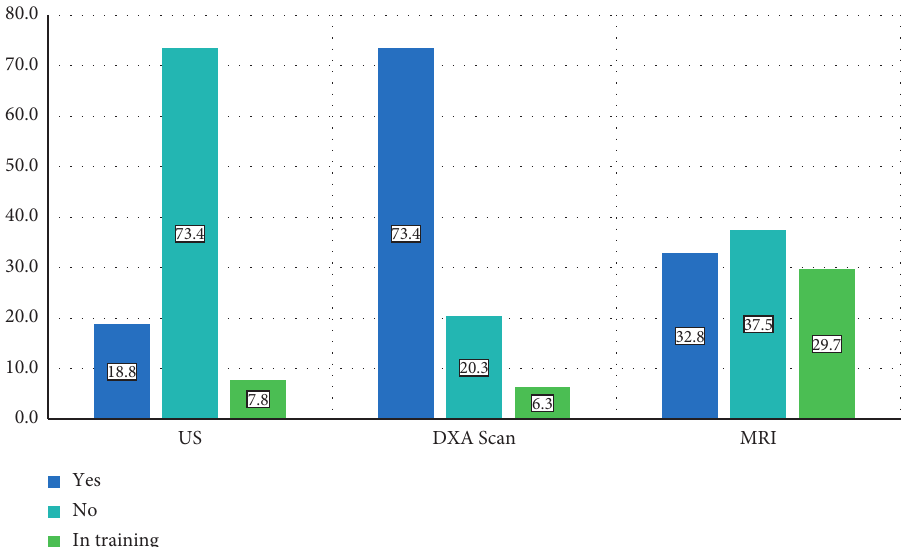
Figure 2: Training in the use of diagnostic